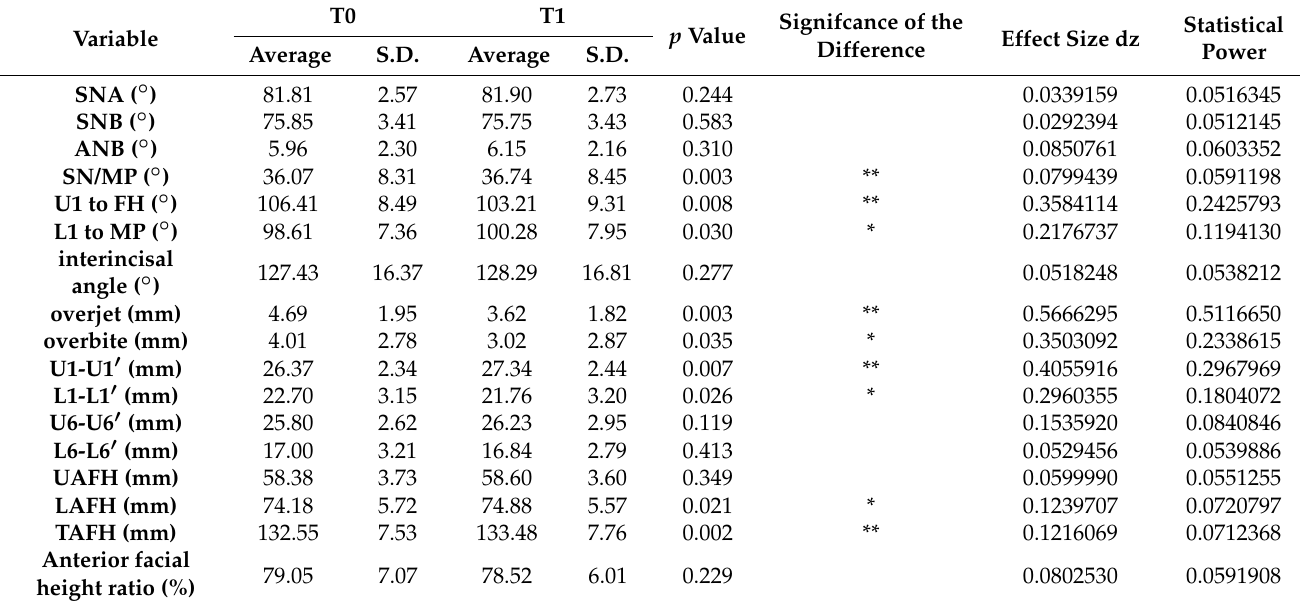
Table 3. Changes in the cephalometric values before and after using the MAD.